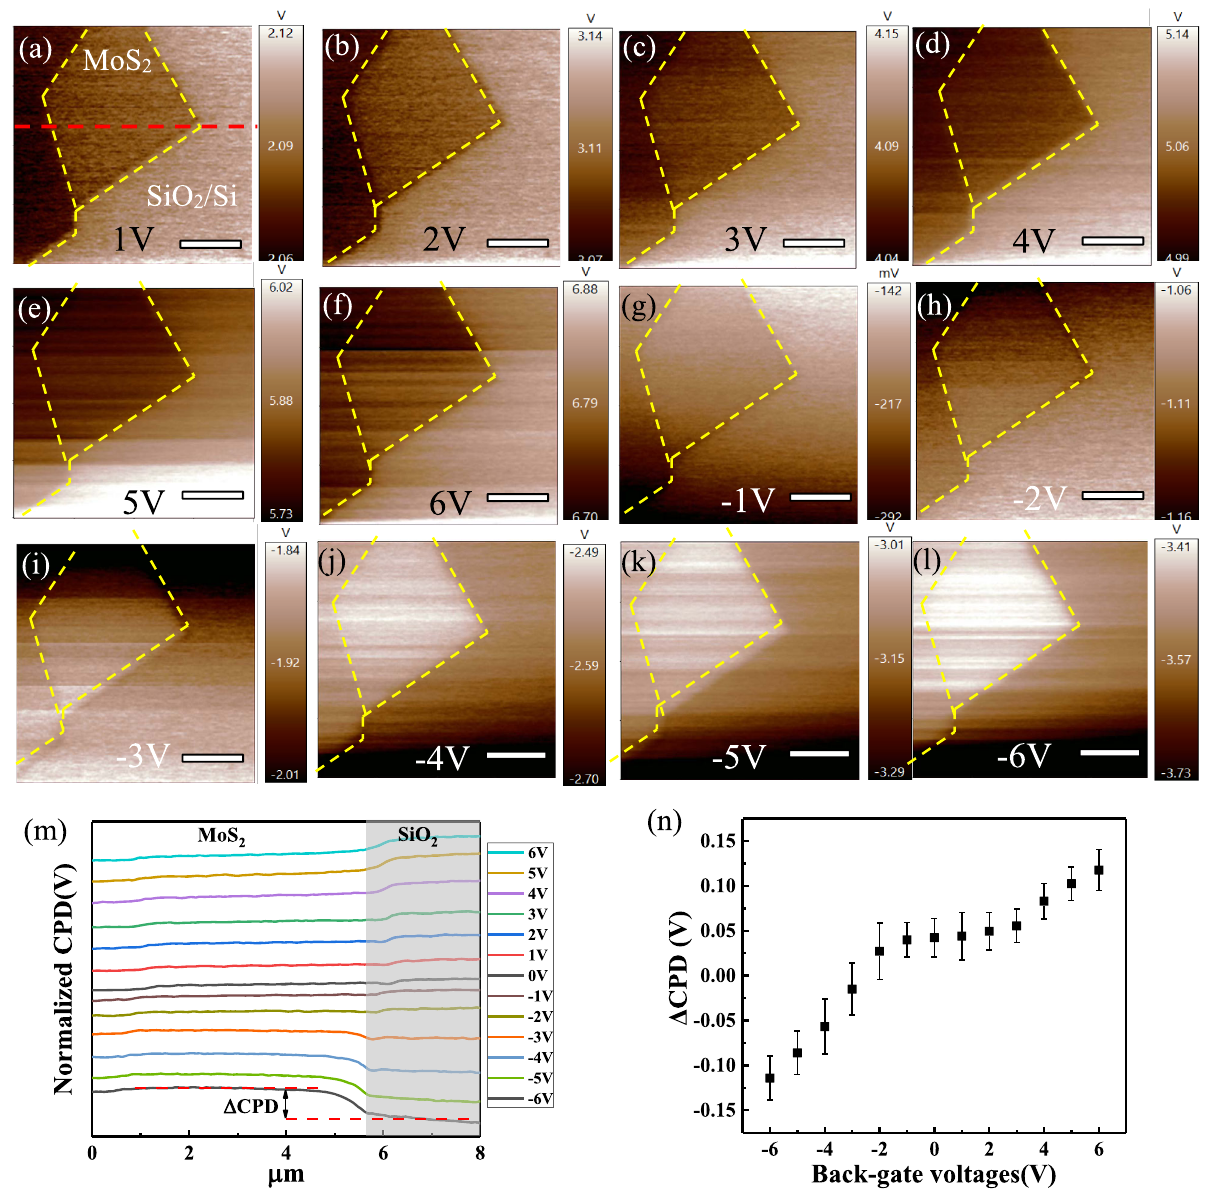
Fig. 4 Surface potential mapping of atomically thin MoS 2 on SiO 2 /Si substrate. a – l The surface potential mapping of atomically thin MoS 2 under different V g : − 6 – + 6 V. Scale bar: 2 μ m. m The line pro fi les of surface potential along the white line across the atomically thin MoS 2 under different V g . n Δ CPD of atomically thin MoS 2 as a function of V g . Error bars represent standard deviations. Supplementary Fig. 8 (Supplementary Information). To minimize the in fl uence of the applied electric fi eld on the SKPM test, the surface potential of SiO 2 was used as the reference. Because the relationship between the surface potential of SiO 2 and gate voltage is linear. The surface potential of SiO 2 is consistent with the V g indicating that the work function of SiO 2 as an insulator is very little affected by the V g . Therefore, the surface potential difference between SiO 2 and MoS 2 ( Δ CPD) was used to re fl ect the effect of electric fi eld on MoS 2 , which is relatively more accurate. The surface potential of MoS 2 deposited on SiO 2 /Si substrate under different V g was shown in Fig. 4a – l. The yellow dotted box denotes the area of the atomically thin MoS 2 on the surrounding SiO 2 /Si substrate. The surface potential of atomically thin MoS 2 increases with the increase of positive V g as presented in Fig. 4a – f. Also, the surface potential of atomically thin MoS 2 decreases with a decrease of the negative V g , as shown in Fig. 4h – l. The potential npj 2D Materials and Applications (2022)